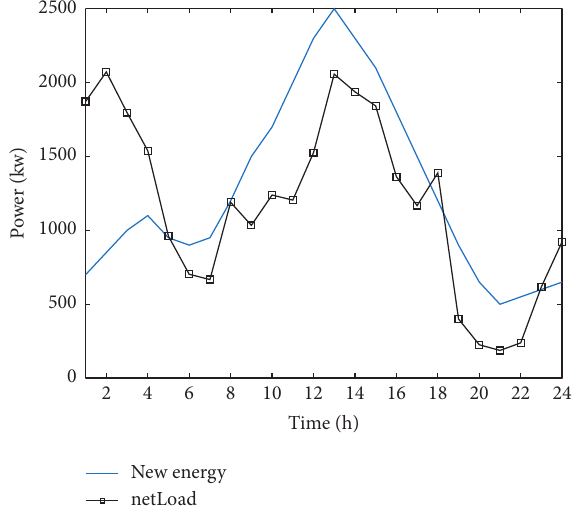
Figure 13: The curve of netLoad and renewables in the strategy without considering the dispatchable